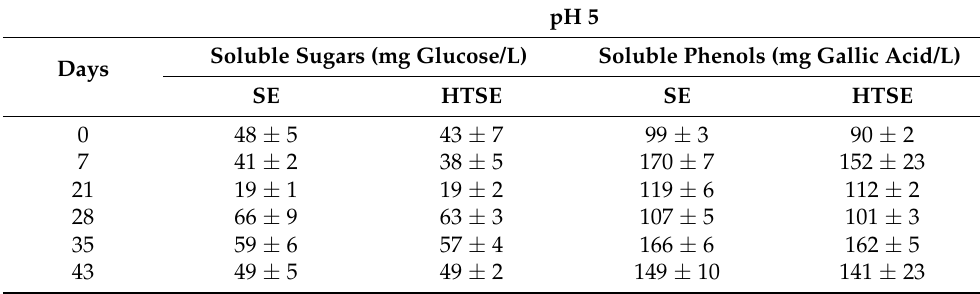
Table 2. Concentrations of soluble sugars (mg glucose/L) and soluble phenols (mg gallic acid/L) at different experimental times.